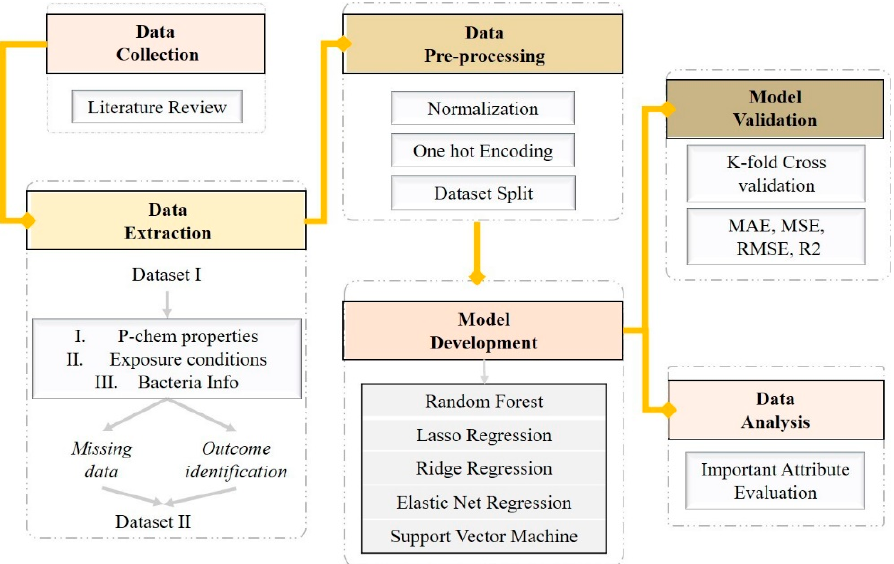
Figure 1. Model development workflow.